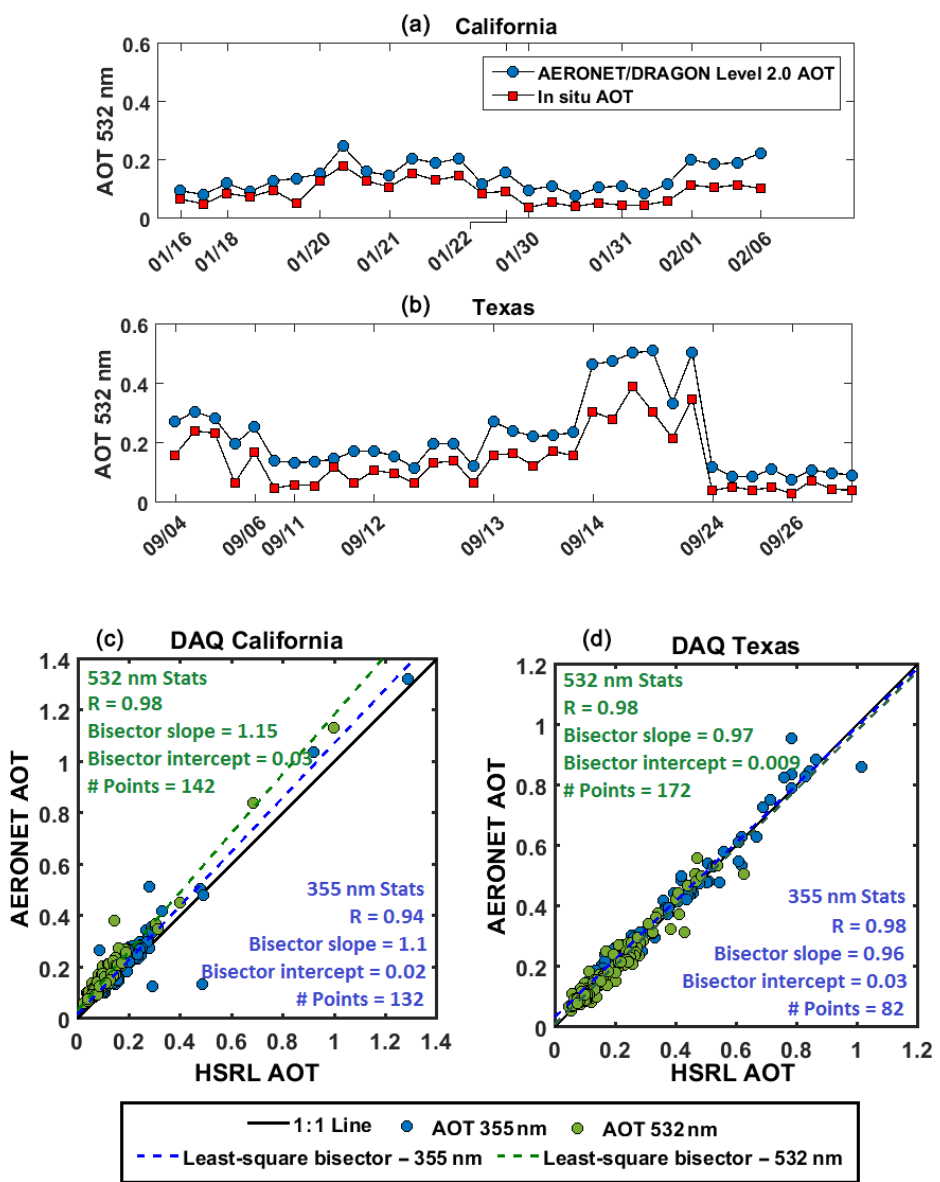
Figure 10. (a, b) AERONET and in situ aerosol optical thickness (AOT) measurements during DAQ CA (a) and TX (b) . In situ values were obtained by vertical integration of the ambient extinction profile. (c, d) Comparison of AOT measurements at 355 and 532nm measured with HSRL-2 and AERONET/DRAGON sun photometers during DAQ California (c) and DAQ Texas (d) . Measurements from AERONET were calculated from level 2.0 measurements of AOT at 340 and 500nm, corrected to 355 and 532nm using Ångström exponents calculated between 340 and 440nm, and 440 and 675nm, respectively. Only measurements obtained within a radius of 2.5km and 10min from each other were